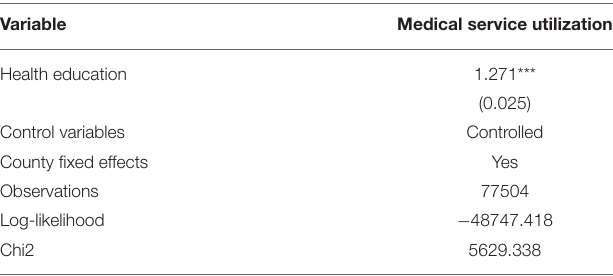
TABLE 5 | The effect of health education on medical service utilization of the migrants (Logit model).